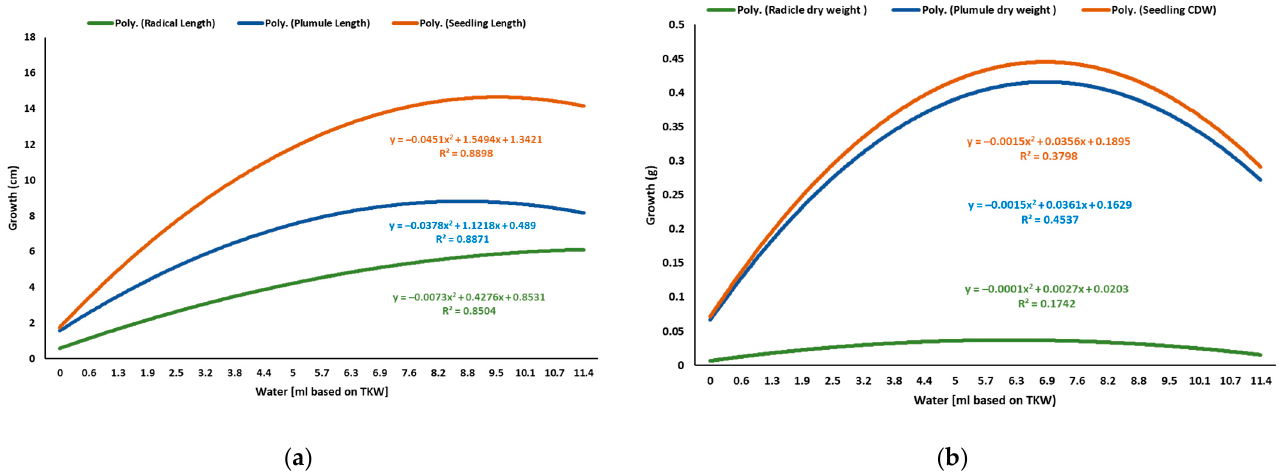
Figure 7. The influence of water quantities on seedling, plumule, and radicle growth. ( a ) Length vs. water according to TKW%. ( b ) Dry weight buildup versus water according to TKW%.